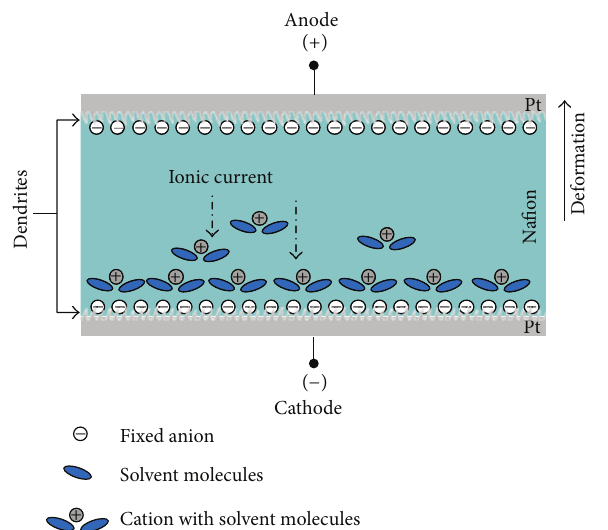
Figure 1: Structure and working principle of IPMC.